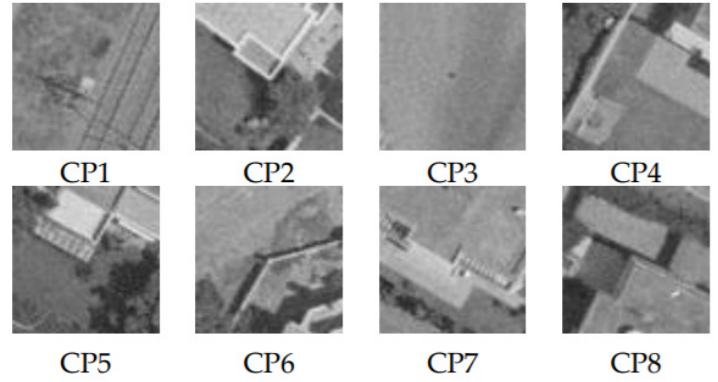
Figure 3. Examples of aerial image templates used in the experiments.